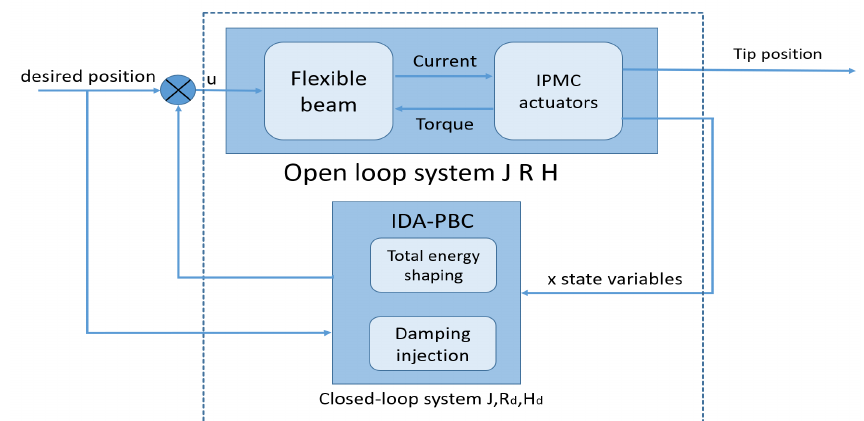
Figure 3. Control